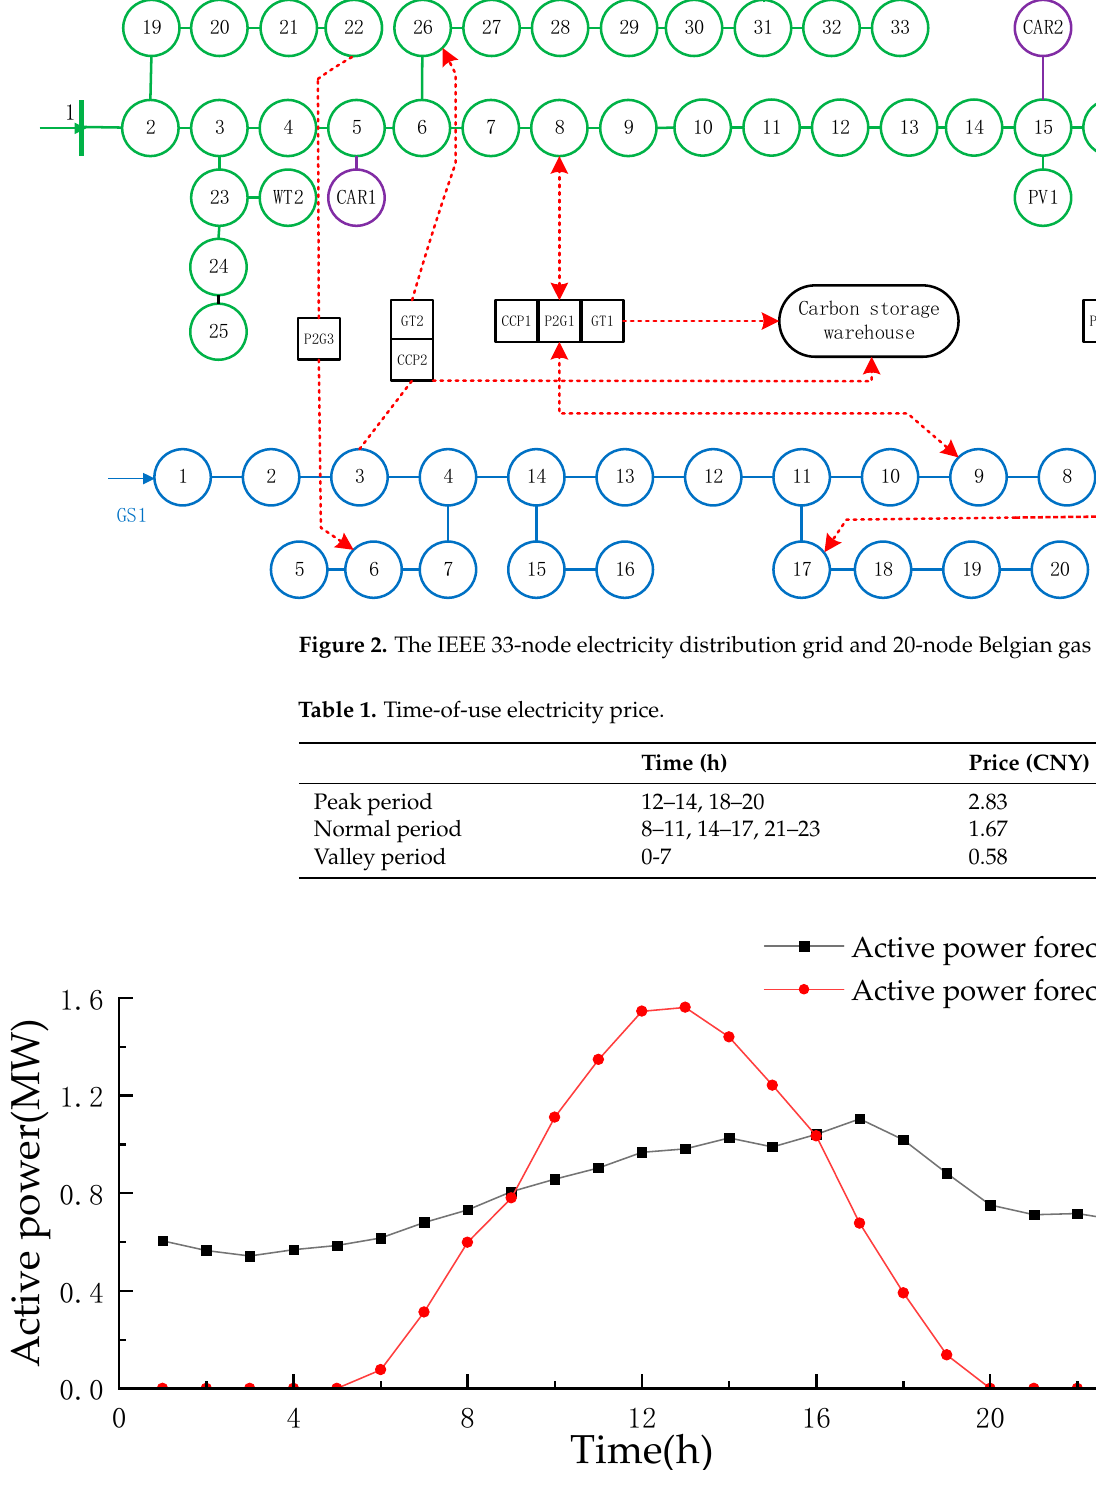
Figure 3. Power generation forecast of WT/PV.